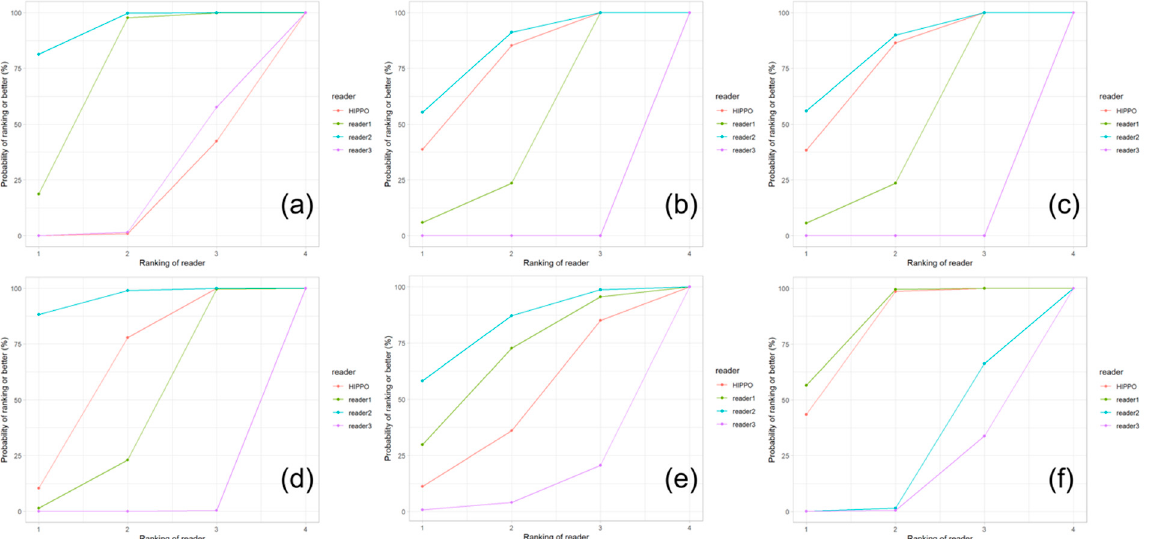
Figure 9. SUCRA (surface under the cumulative ranking) plots for ( a ) CCD, ( b ) extrusion index, ( c ) femur head coverage, ( d ) LCE, ( e ) Sharp angle, and ( f ) Tönnis angle. The plots indicate the probabilities that a reader ranks better (i.e., less absolute deviation from the median) than a certain rank.